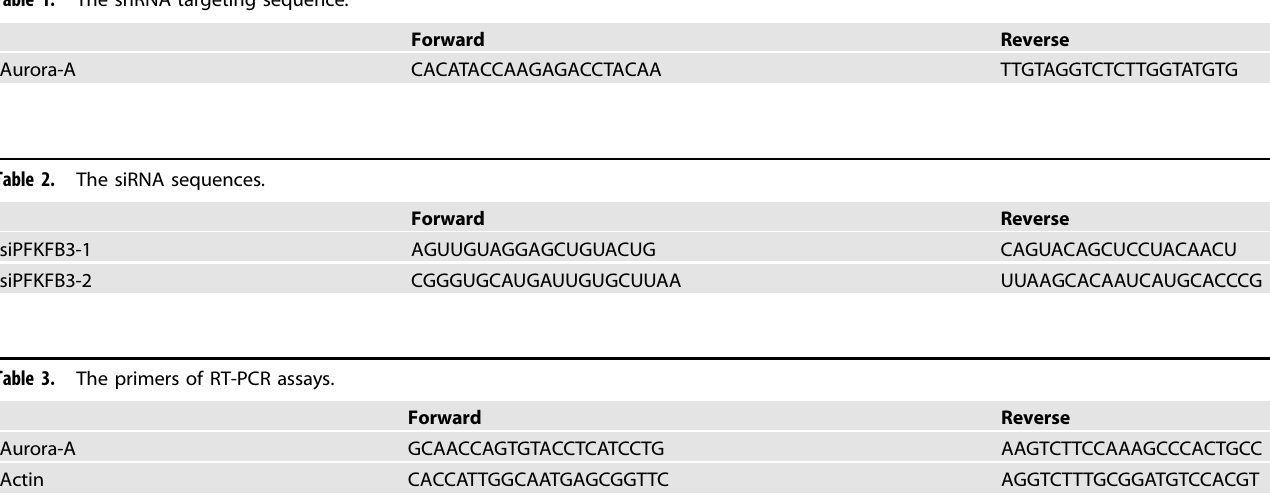
Table 1. The shRNA targeting sequence.